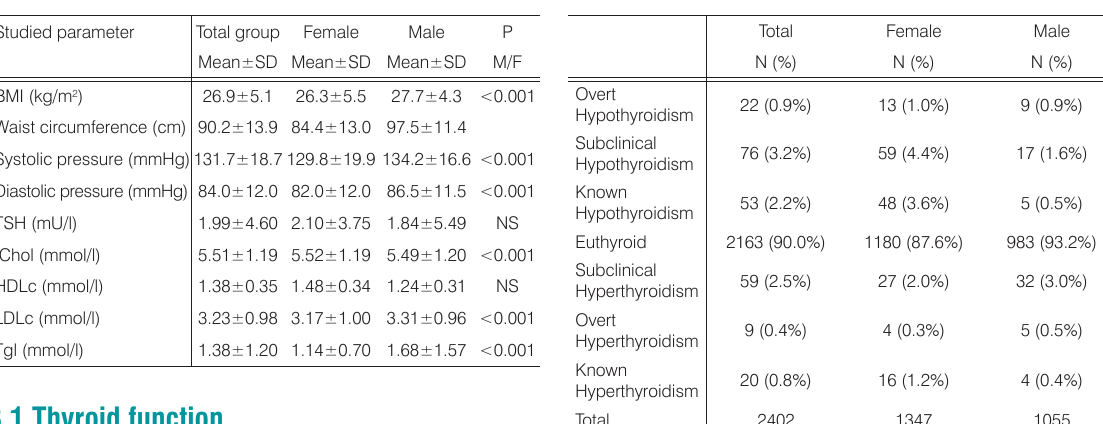
Table 1. Anthropometric and laboratory data of the studied subjects. Table 2. Types of Thyroid Dysfunction in the studied subjects by gender.